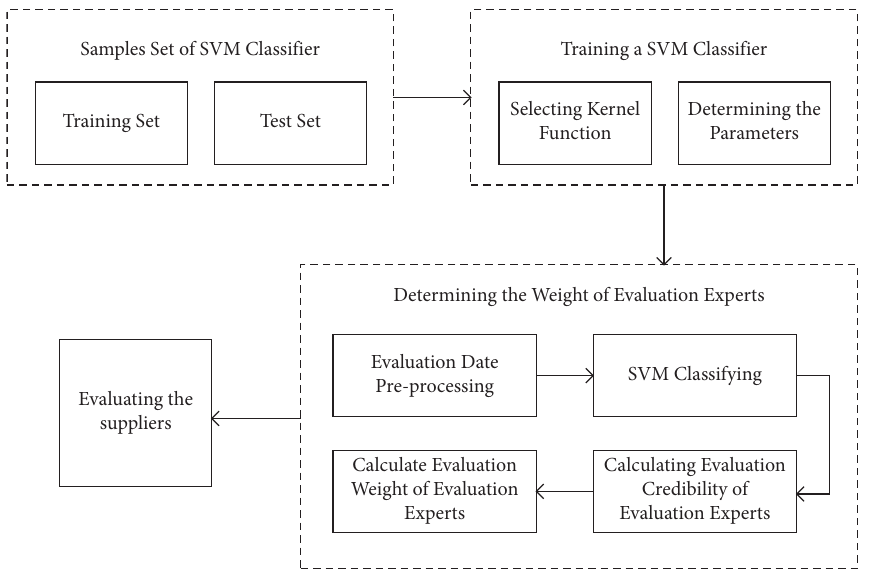
Figure 2: Workflow of our